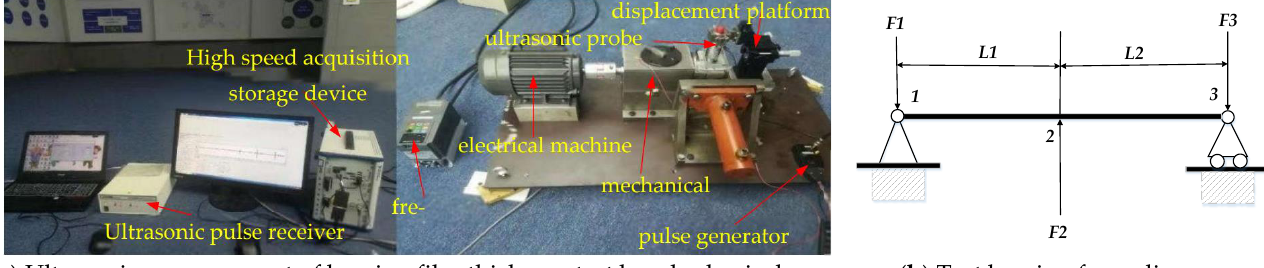
( b ) Figure 9. Distribution of oil film pressure and film thickness at different −𝑋 𝑖𝑛 values. ( a ) −𝑋 𝑖𝑛 = 1.01 ; ( b ) −𝑋 𝑖𝑛 = 2.75 . 5. Experimental Verification The oil film thickness of the bearing is measured by an ultrasonic measuring instru- ment, and the numerical calculation results of the theoretical calculation model are veri- fied in this paper. The testing machine includes a driving device, loading device, control device, measurement and data processing system and a lubrication system [31]. Figure 10a shows the bearing film thickness ultrasonic measurement test bench phys- ical diagram, mainly by the bearing test bench, ultrasonic pulse receiver, high-speed ac-